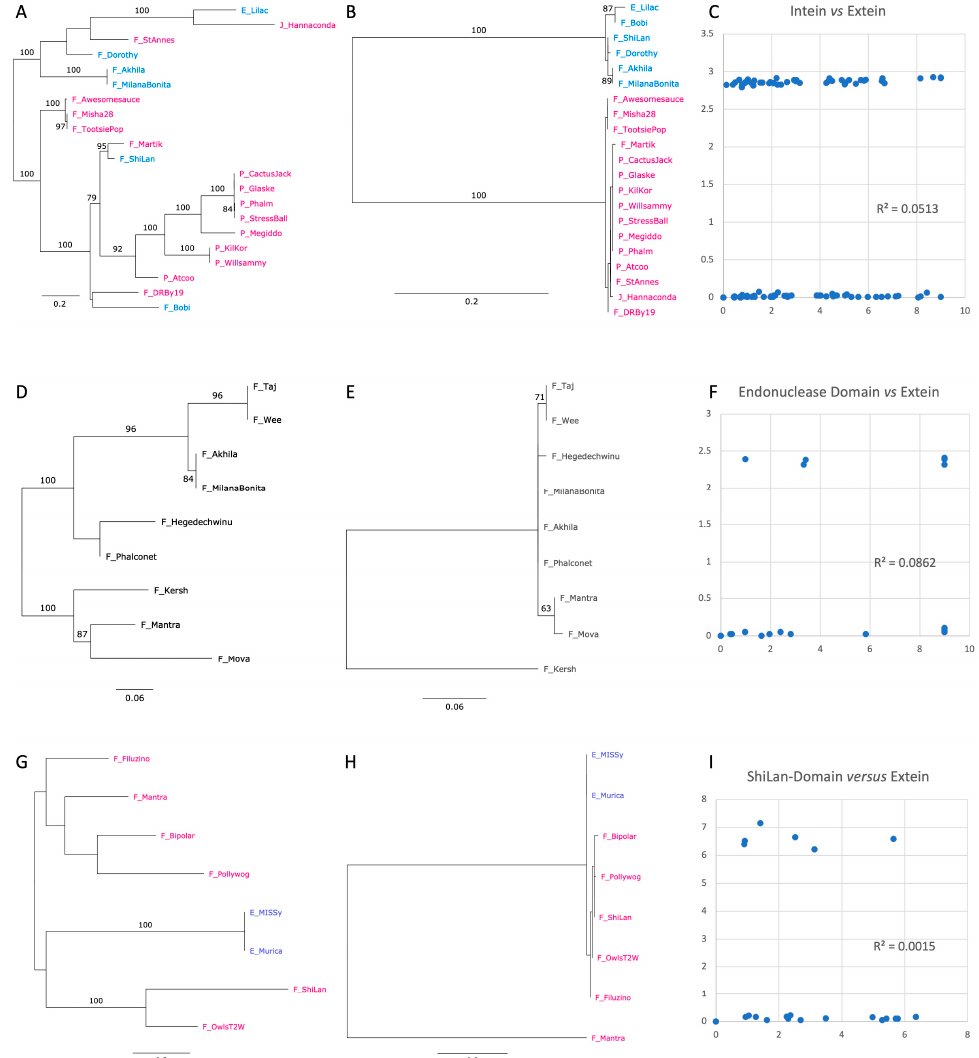
Figure 6. Phylogeny of subsets of the methylase family (panels A , D , G ) compared to the phylogenies of the intein ( B ), second endonuclease, ( E ) and ShiLan domain (panel H ). The phage names in panels ( A,B ) are colored to reflect the two intein groups. Phage names in panel ( G , H ) are colored to reflect the clusters to which the phage belongs. Panels ( C,F,I ) plot the pairwise maximum likelihood (ml) distances for the inserted element against the ml distances of the extein sequence.